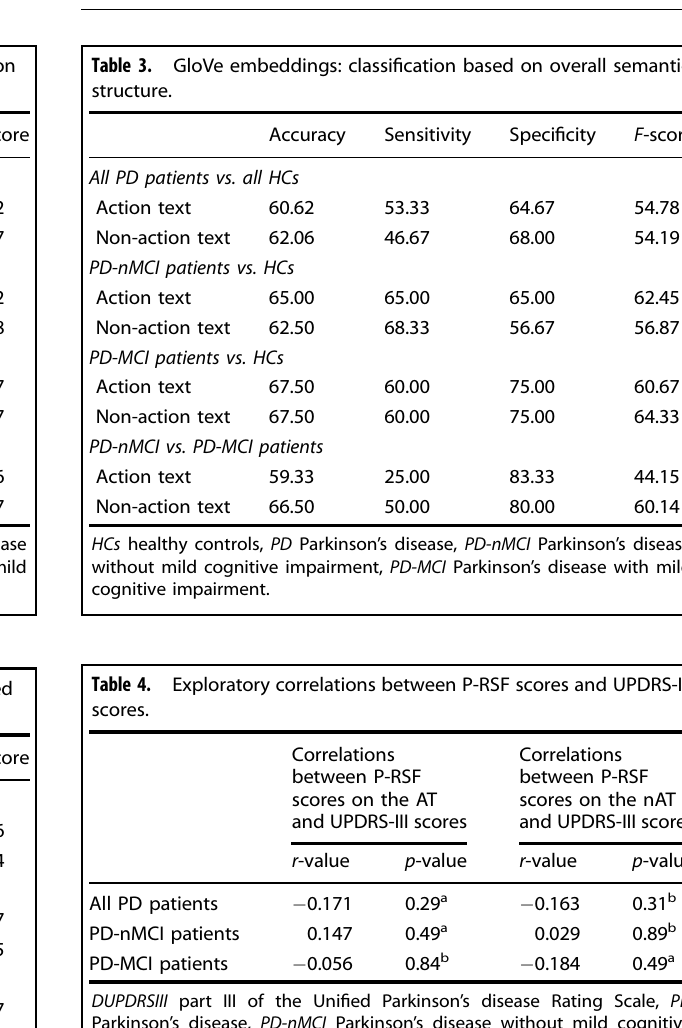
impairment, PD-MCI Parkinson ’ s disease with mild cognitive impairment. a Based on Pearson ’ s correlations, given the data distribution. b based on Spearman ’ s correlations, given the data